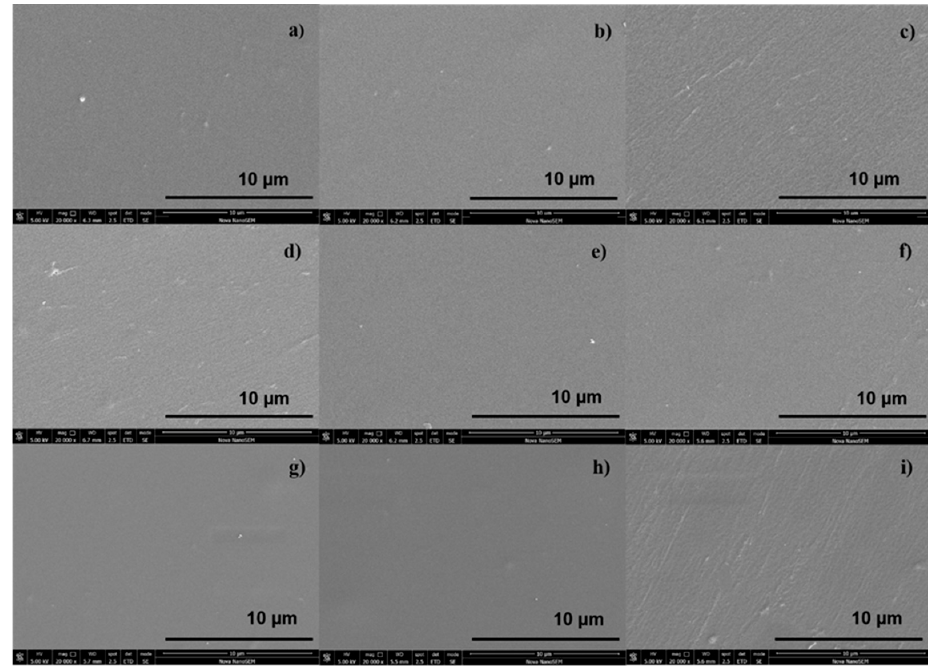
Figure 2. SEM images of ( a ) untreated PET, ( b ) PET_DC, ( c ) DC_MAAM, ( d ) MAAM_1000, ( e